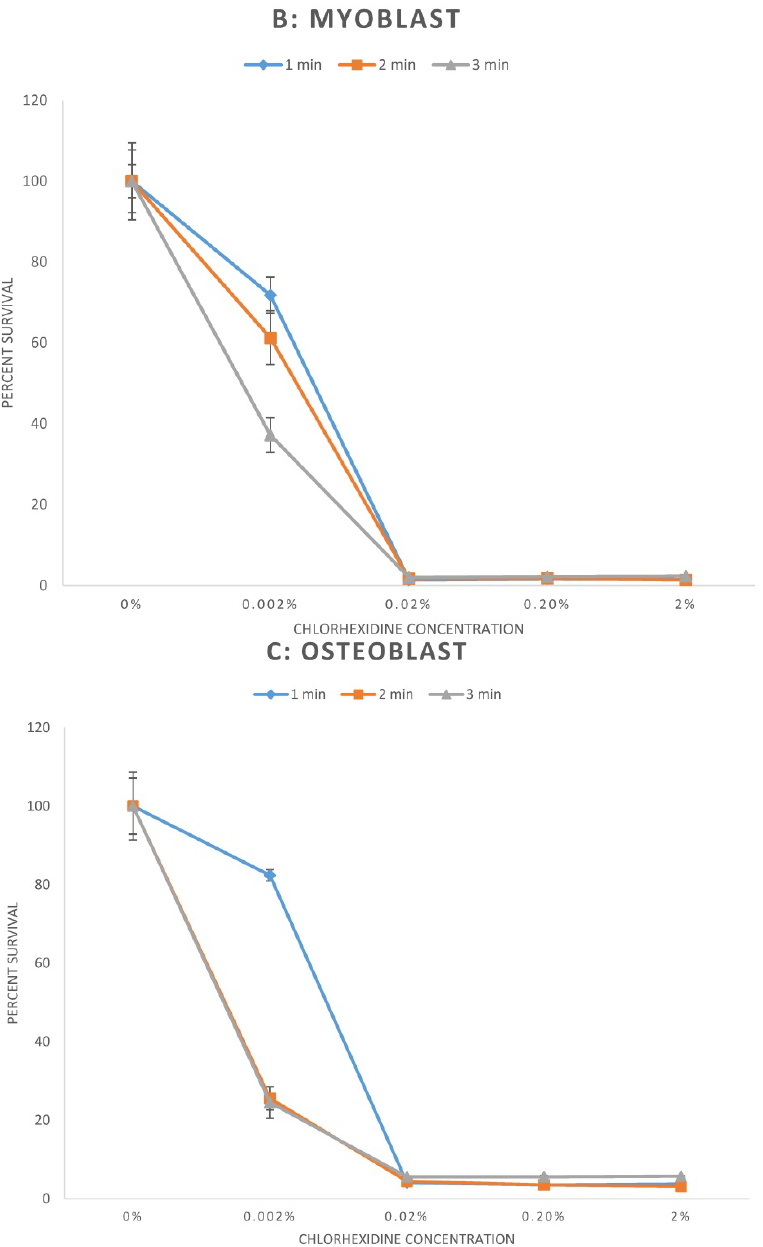
Figure 1. A-C: Percent survival of cells 48 hours after exposure to different concentrations of chlorhexidine gluconate for 1, 2, and 3-minute durations. A) Fibroblast B) Myoblast C) Osteoblast